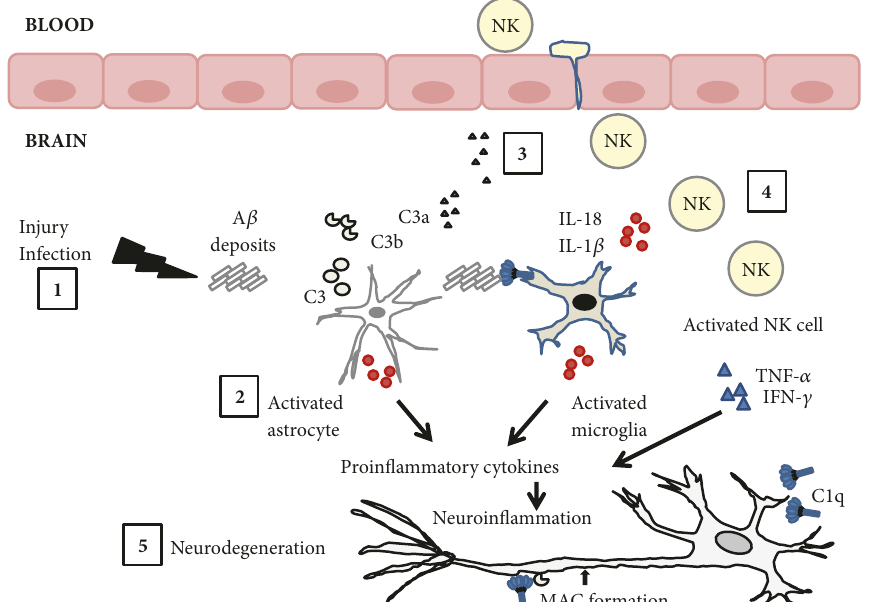
Figure 2: A m o d el o f NK cell involve m ent in Al z hei m er ’ s d isease . Injury or infection can lead to the accumulation of A 𝛽 peptides in the brain (1) and stimulates microglia and astrocytes (2). Accumulation of A 𝛽 forming plaques induces the activation of complement system. C1q secreted by neurons can bind A 𝛽 and activates C1q receptor (C1qR) on microglia promoting phagocytosis of A 𝛽 . In addition, activated microglia secretes the proinflammatory cytokines IL-1 𝛽 and IL-18.Astrocytes stimulated by inflammatory signals secrete C3 that is cleaved into C3b and C3a. C3a mediates recruitment of immune cells. This inflammatory environment can support trafficking of peripheral NK cells into the brain (3). NK cells are activated by microglia secreted cytokines and produce IFN- 𝛾 and TNF- 𝛼 (4). Complement activation and proinflammatory cytokines can lead to neuronal damage and death